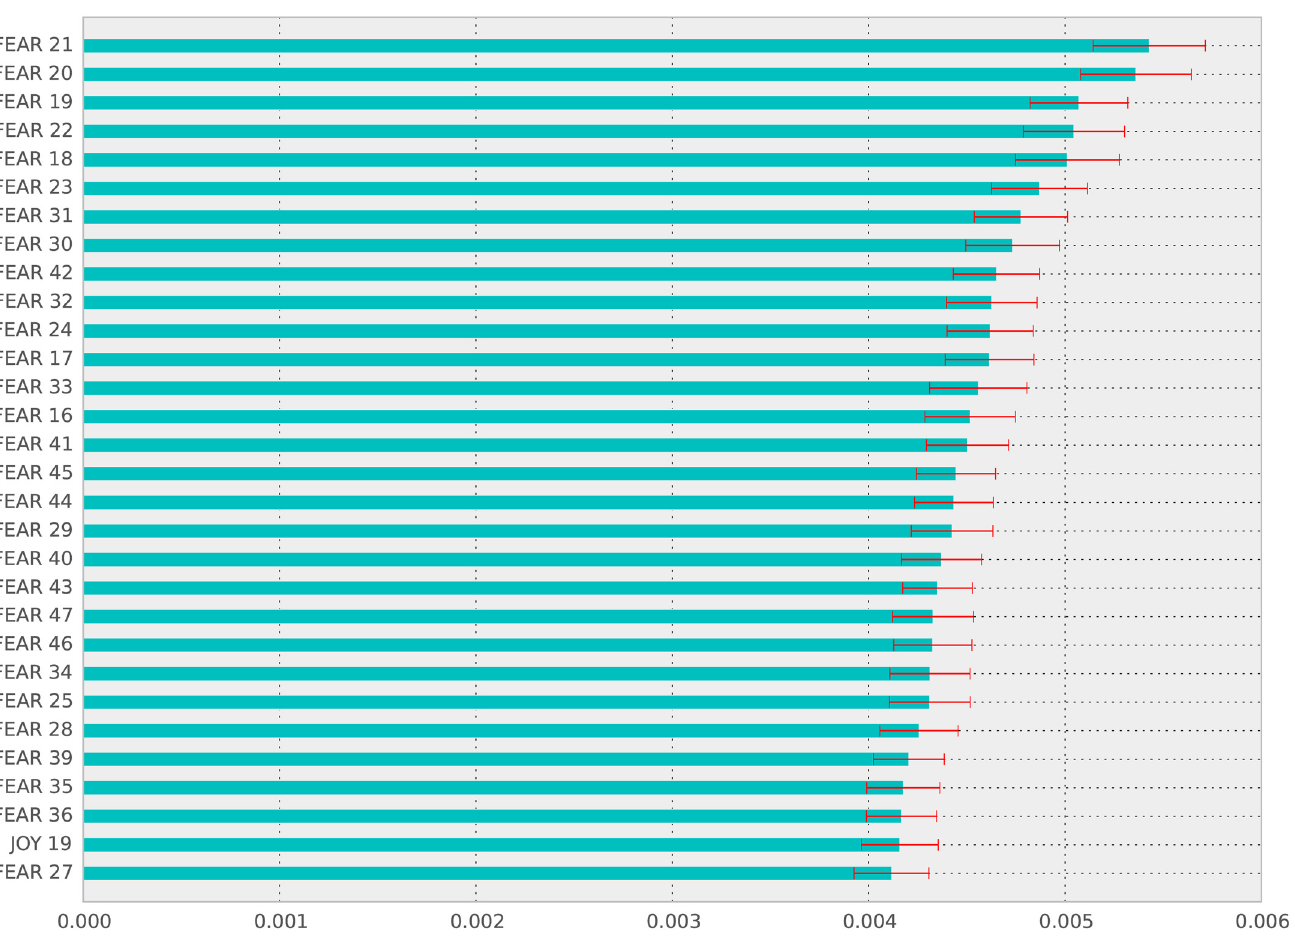
Fig 4. Feature importances, with a = 0.05 confidence intervals